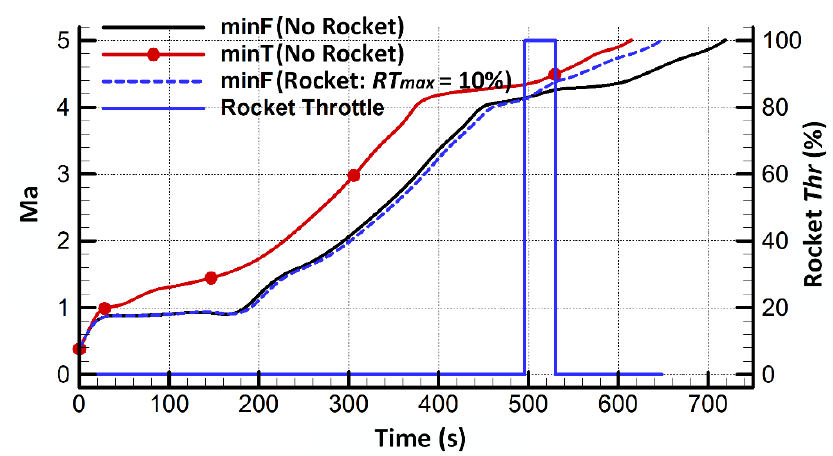
Figure 5. Flight time profiles.